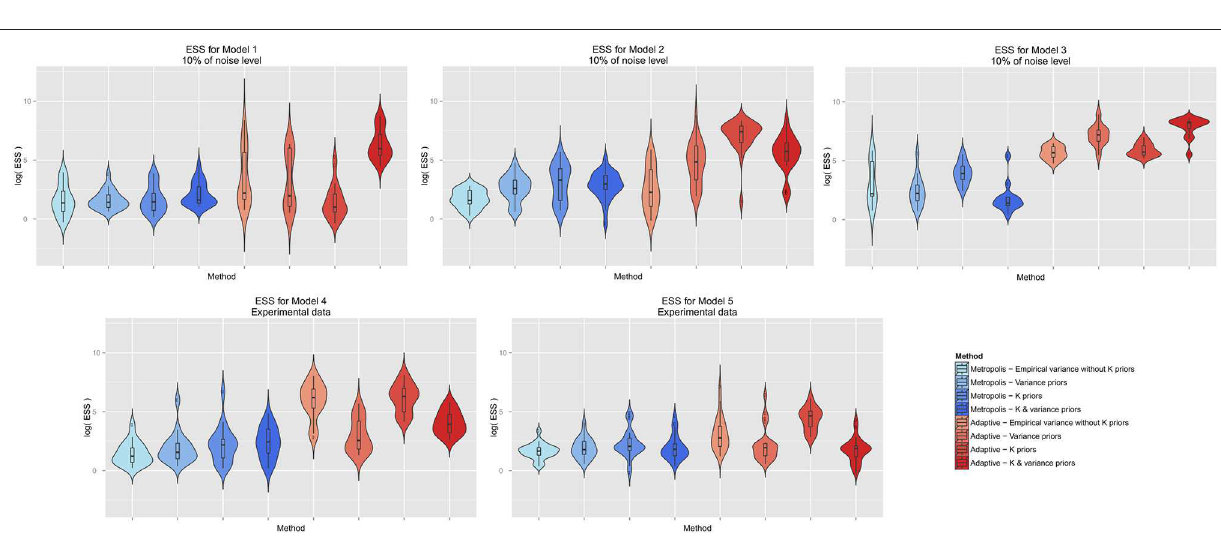
FIGURE 6 | Influence of informative Bayesian priors on effective sample size. The y-axis is on